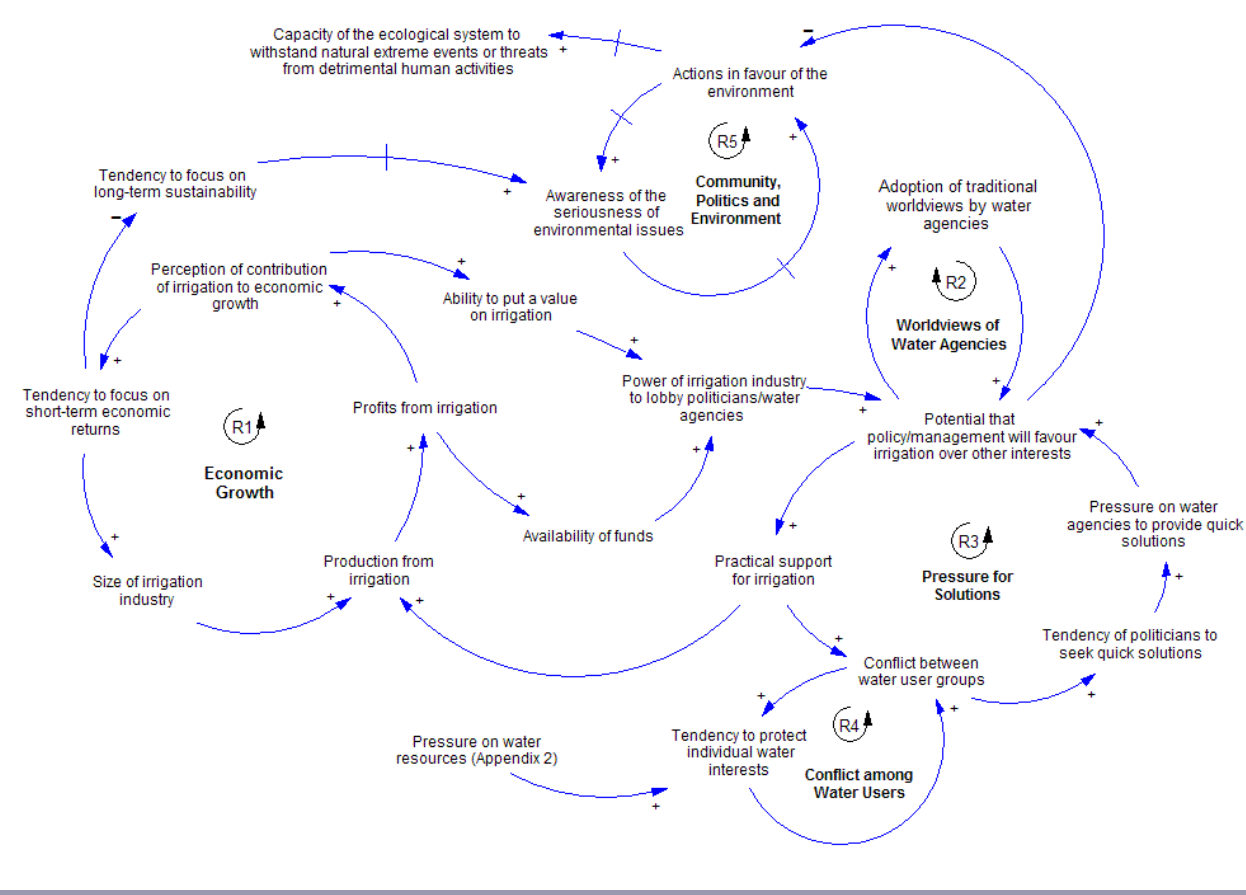
Fig. 7. The Marshes system. Key variables in the individual causal loop diagrams (CLDs) described in Figs. 3-6 collectively illustrate important connections between the subsystems. With this wider view of the system, additional feedback dynamics become visible. The loop labelled Economic Growth (R1) is linked to Pressure for Solutions (R3) via the power of the irrigation industry to lobby politicians or water agencies. The loop labelled Worldviews of Water Agencies (R2) is linked to Pressure for Solutions (R3) via the potential for policy/ management to favour irrigation over other interests. The loop labelled Conflict among Water Users (R4) is linked to Pressure for Solutions (R3) via conflict between water user groups. These links form part of the positive feedback behavior driving the system. Increasing potential for policy and management to favor irrigation decreases actions in favor of the environment (R5), while a decreasing tendency to focus on long-term sustainability decreases awareness of the seriousness of environmental issues (R5). This ultimately leads to a decrease in the capacity of the Macquarie River to withstand extreme natural events or threats from detrimental human